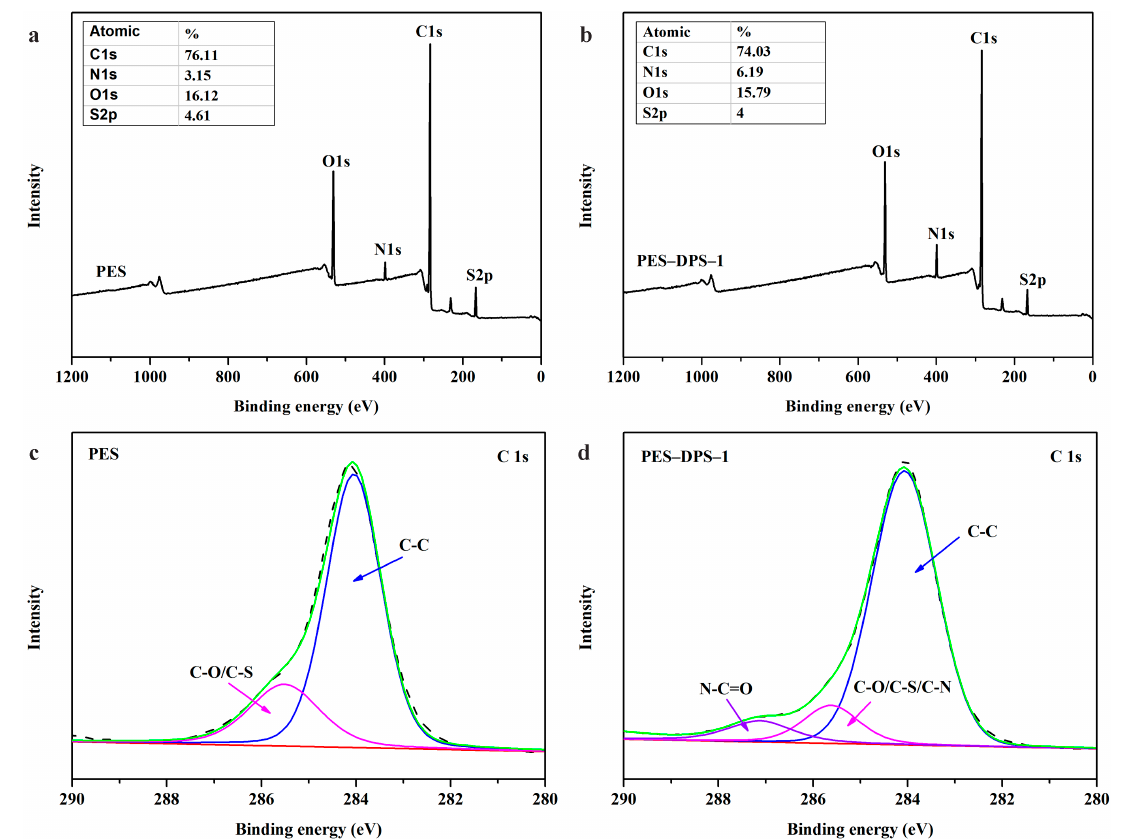
Figure 6. ( a , b ) XPS survey spectrum and atomic content (C, N, O, S) of PES and PES–DPS–1 mem- branes; and ( c , d ) high-resolution C1s spectra of PES and PES–DPS–1 membranes (Black dashed lines represent the original value, green lines represent the fitted value, and red lines represent the background value in the subfigures c , d , respectively).